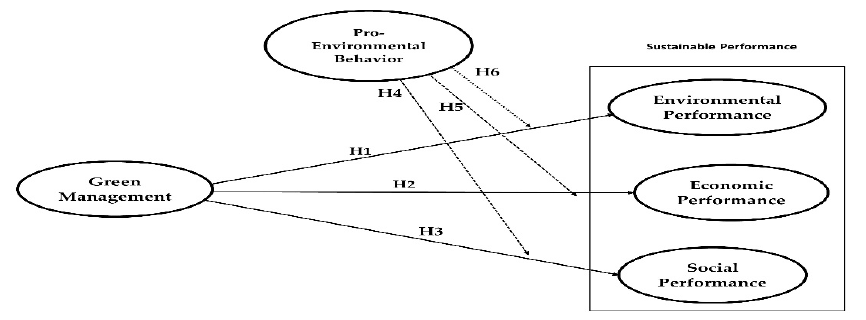
Figure 2. The research model. Dotted line: moderating effects; solid lines: direct